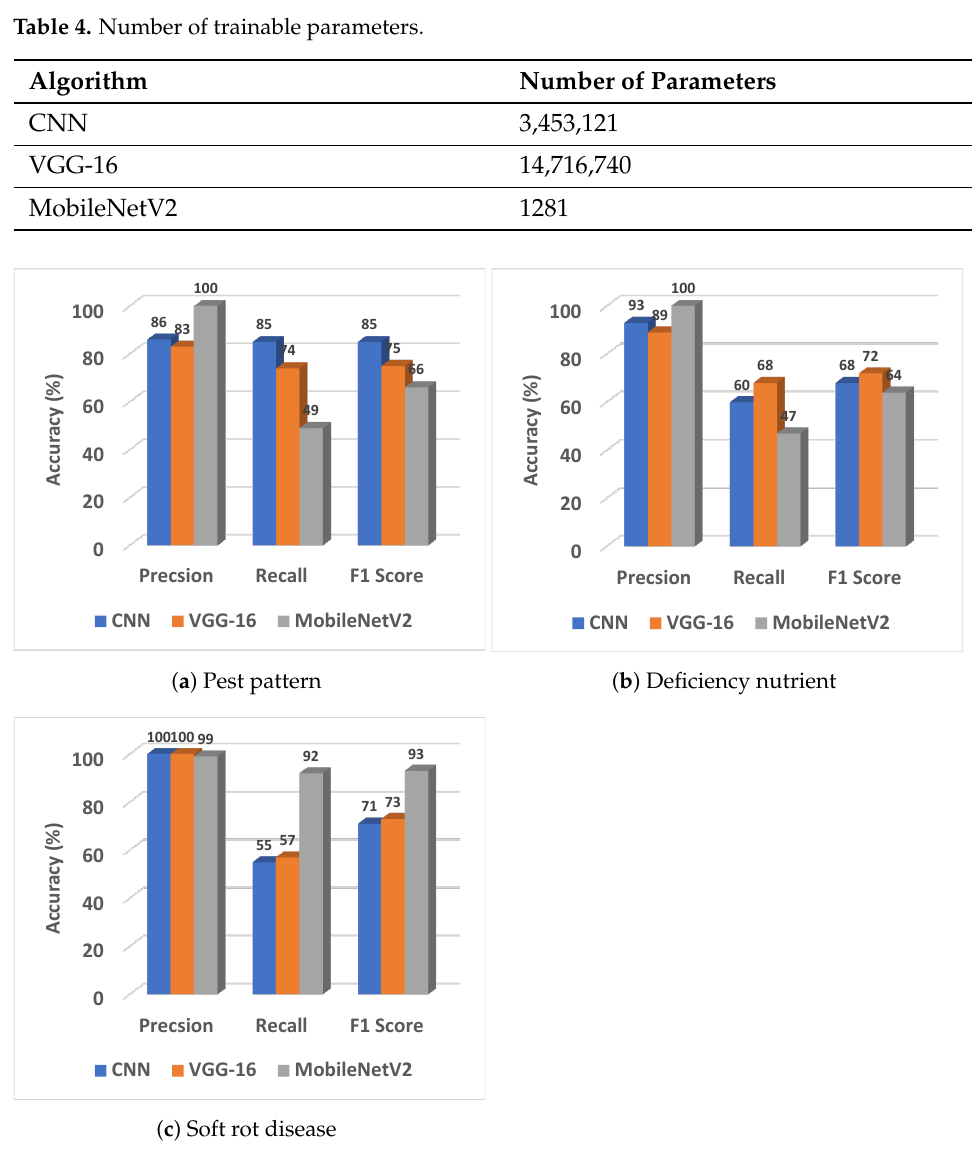
Figure 10. Overall average precision, recall, and F1-score. Extensible Markup Language (XML) and the Android SDK were used to develop the smartphone application. A smartphone was deployed to accomplish the task of the detection of disease, nutritional deficiency, and pest patterns in a real-time environment. This android application was combined with deep learning models to track the results of classification models. We converted the models of the type .h5 file into type .tflite file for converting and using in the android